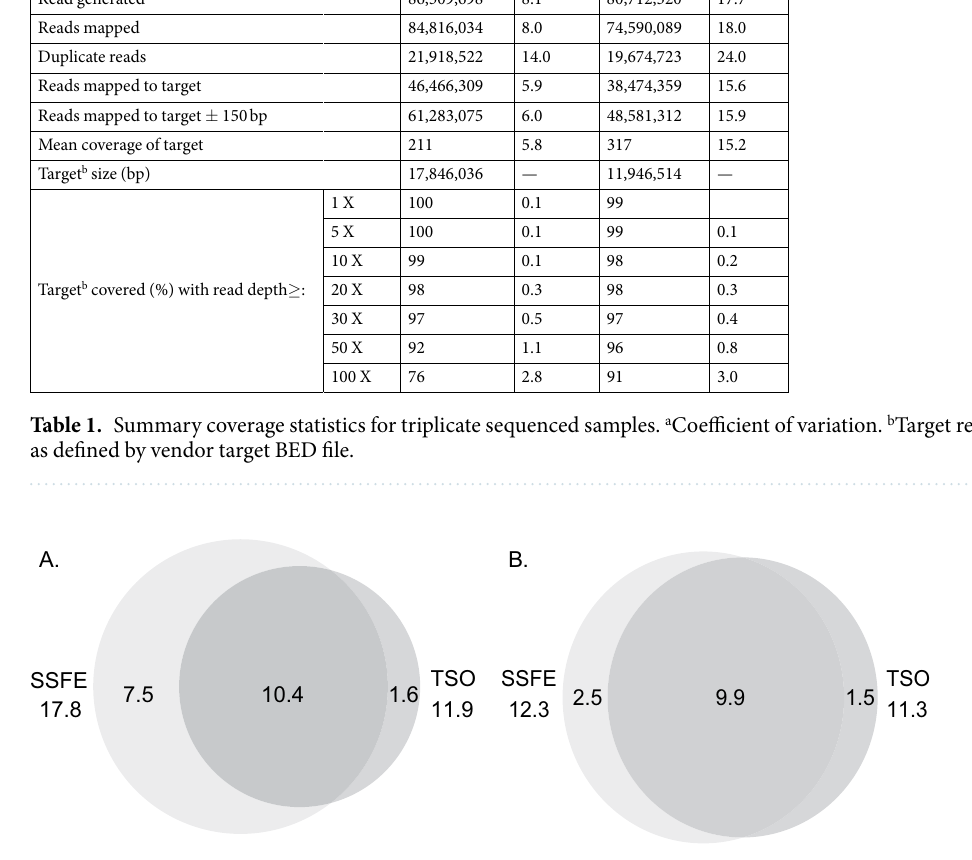
Figure 1. Euler diagram showing size (Mb) of regions as defined by the vendor provided target locations ( A ) and RefSeq transcripts covered to ≥ 20 X in our data without regard for vendor defined targets ( B